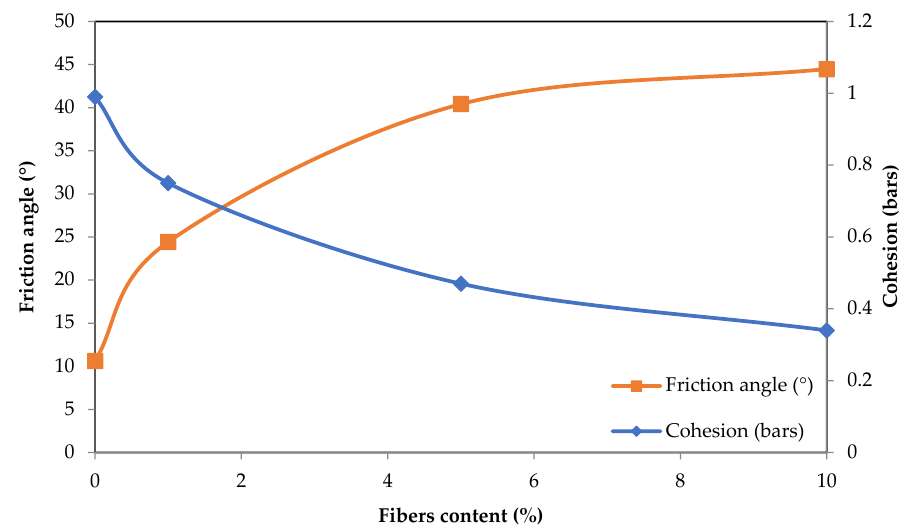
Figure 12. Variation of the mechanical shear characteristics according to the Diss fibers ’ content.